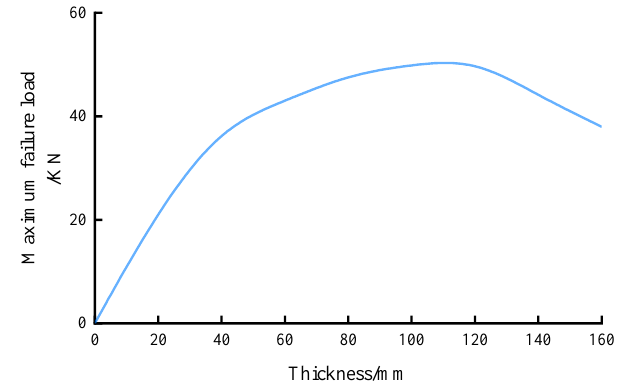
Figure 12. Relationship curve of maximum failure load and thickness.